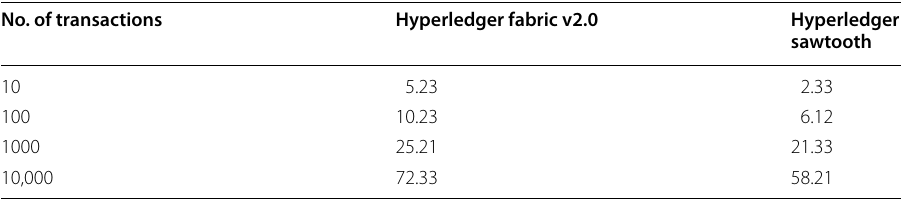
Table 6 Execution time—validation process No. of